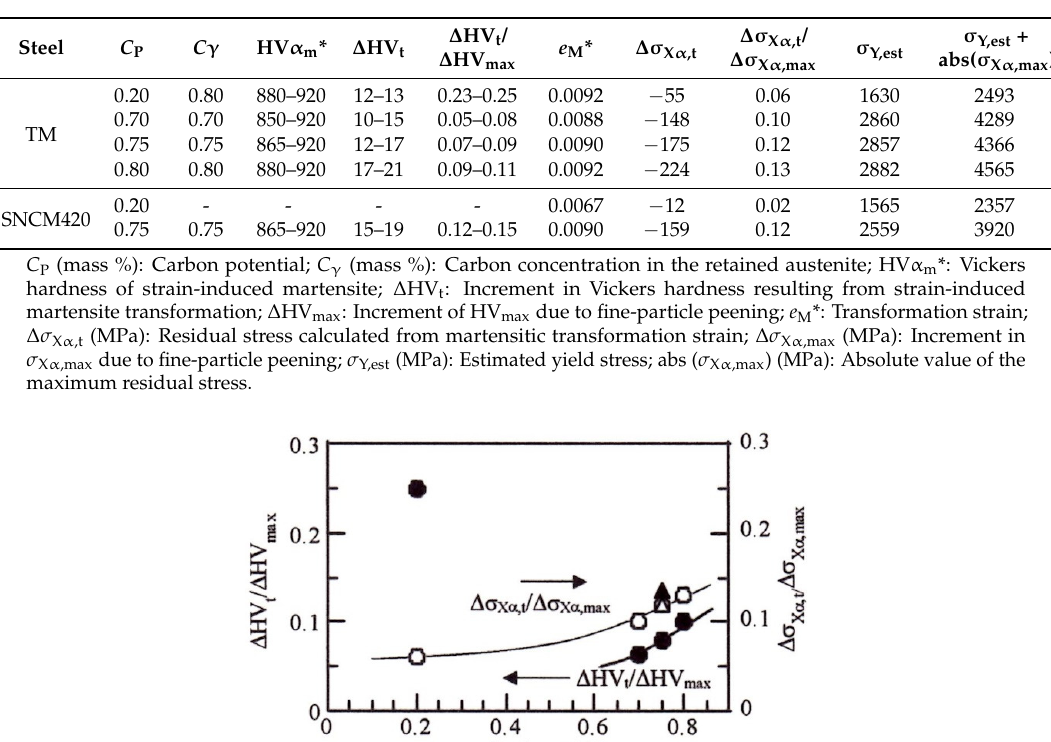
Table 4. Estimated surface-hardened layer properties of TM and SNCM420 steels subjected to vacuum-carburization under various carbon potentials and subsequent fine-particle peening.